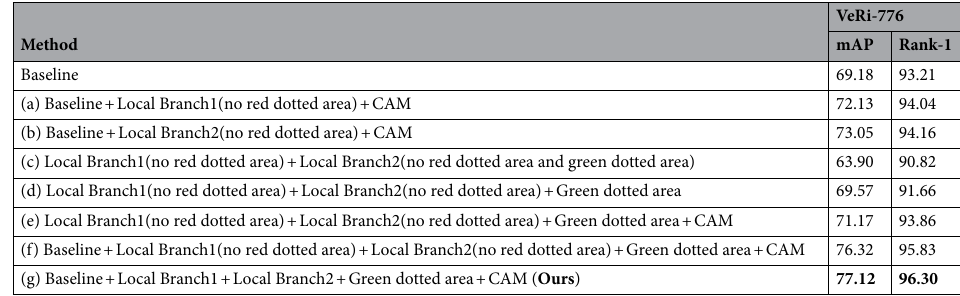
Table 4. The ablation studies on VeRi-776 dataset (in %). Bold indicate the best results for the corresponding metrics.